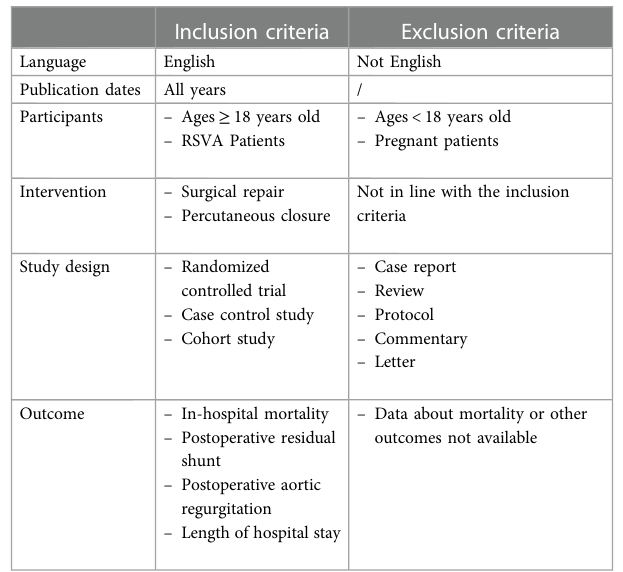
TABLE 1 Meta-analysis inclusion and exclusion